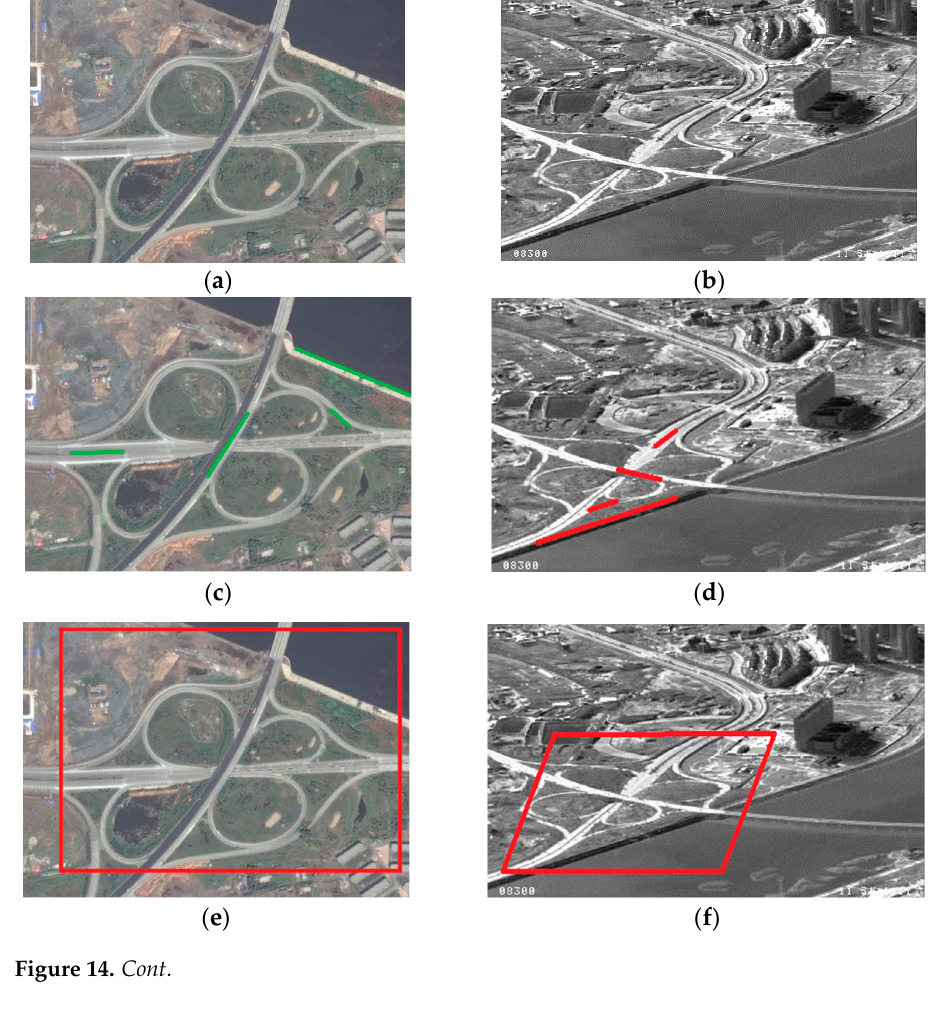
Figure 14. Scene 2 visible light target matching. ( a ) Template; ( b ) real-time graph; ( c ) extract lines from templates; ( d ) extract lines from real-time graphs; ( e ) position in template; ( f ) position in real- time map; ( g ) SURF. Table 2. T arget recognition accuracy. Scene